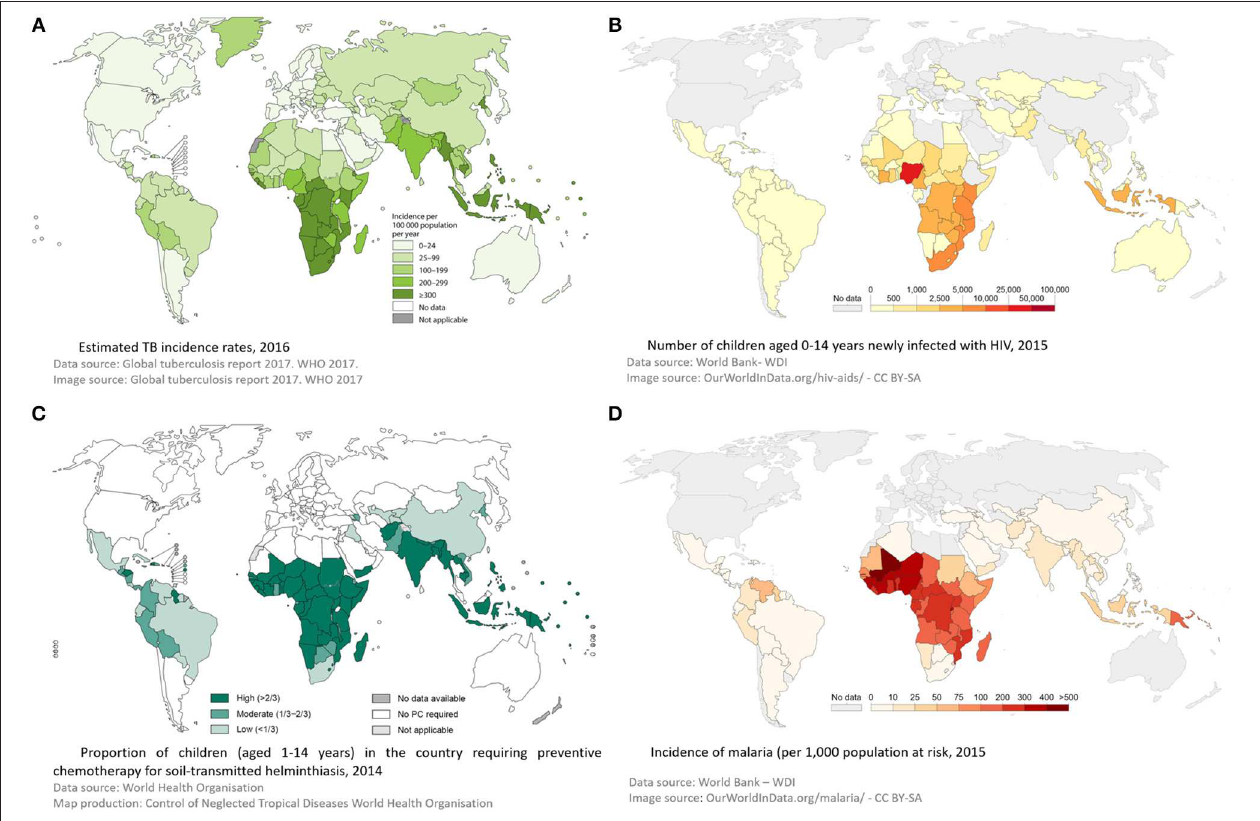
FIGURE 3 | Global incidence of tuberculosis (A) , HIV (B) , Helminths (C) , and malaria (D) —demonstrating geographical overlap between these 4 infections, supporting a role for interplay between them. Panel (A) was reproduced from © World Health Organization ( 2). Panel (B) was reproduced from © World Bank -WDI (6). Panel (C) was reproduced from © World Health Organization 2015 (7). Panel (D) was reproduced from © World Bank -WDI (8). Data from WHO Malaria Report